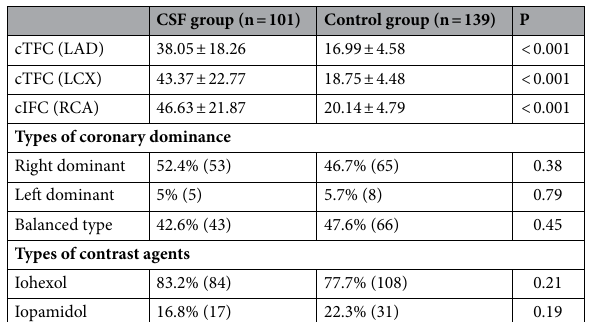
Table 2. Coronary angiography and coronary slow flow pattern. Values shown are means ± SD or percentages. CSF coronary slow flow, cTFC corrected TIMI frame count, LAD left anterior descending, LCX left circumflex, RCA right coronary artery.